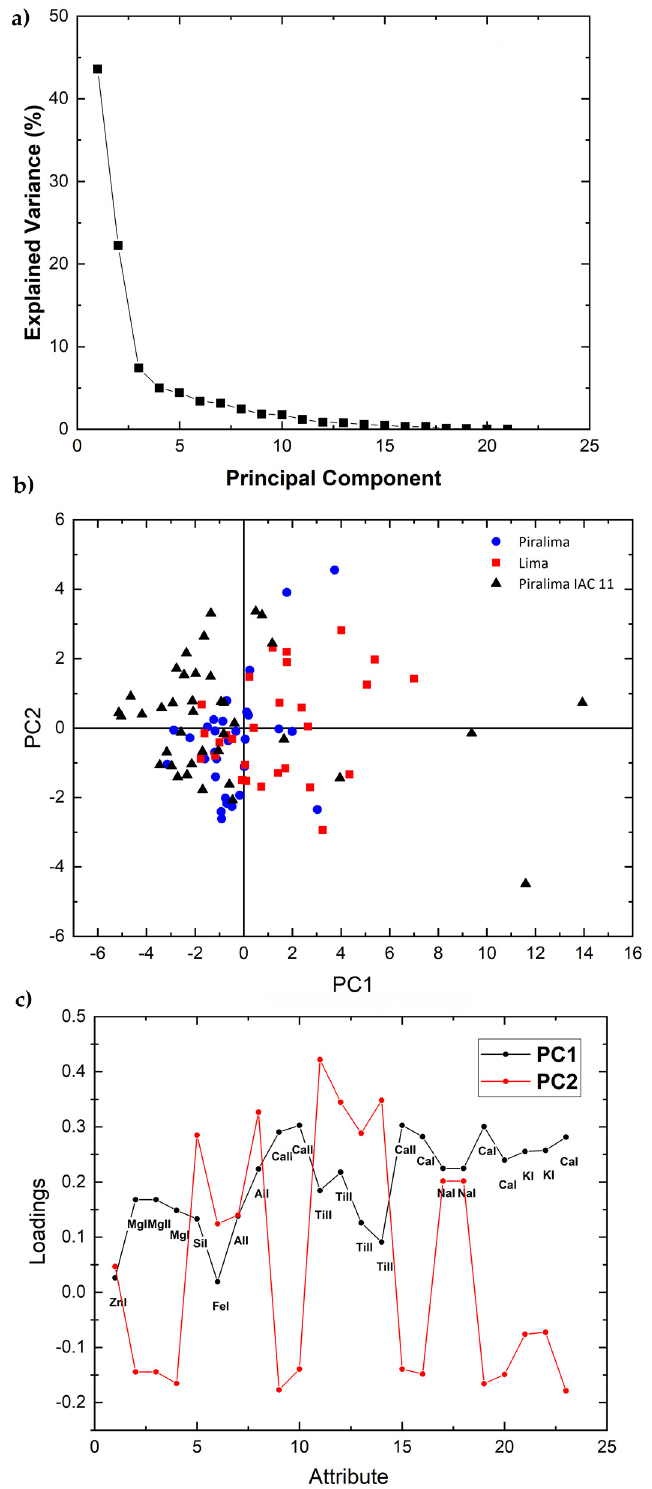
Figure 7. Scree plot ( a ), PCA 2-dimensional score plot of PC2 versus PC1 ( b ), and loading plot showing how each variable correlates to each PC ( c ) for the three accessions of the Low Acidity variety of set 2.